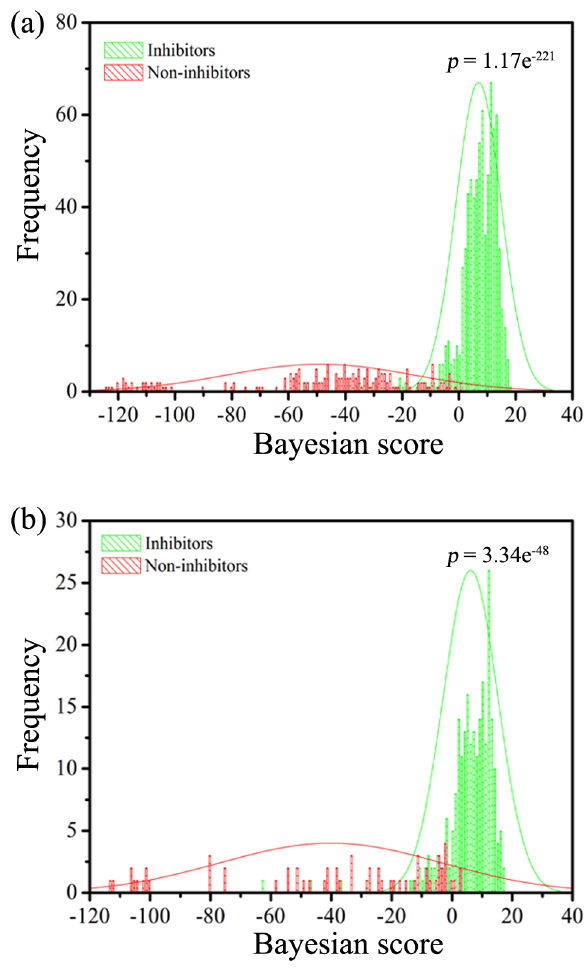
Figure 7. The distributions of Bayesian score predicted by the Bayesian classifier based on molecular properties and the LCFP_6 fingerprint set for the inhibitor and non-inhibitor classes for (a) the training set and (b) the test set. The Bayesian scores for the training set were obtained by sing the leave-one-out (LOO) cross-validation